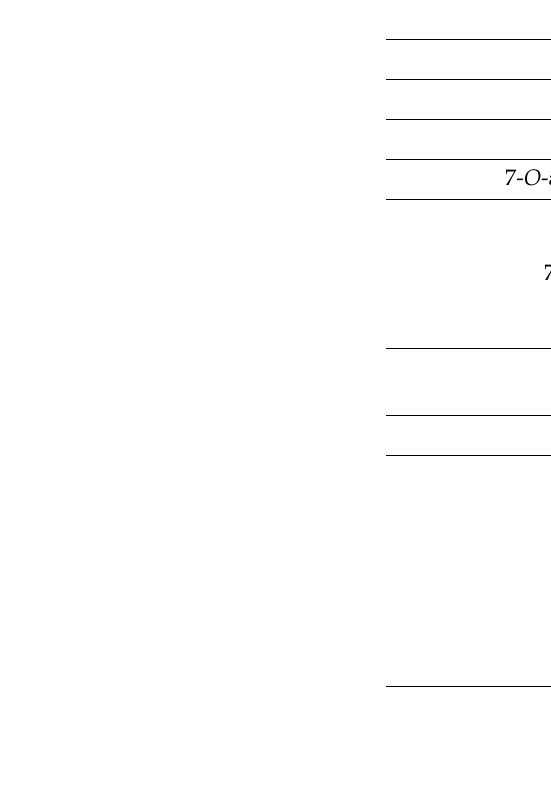
Phytochemical Class Phytochemical Compound Pedicularis